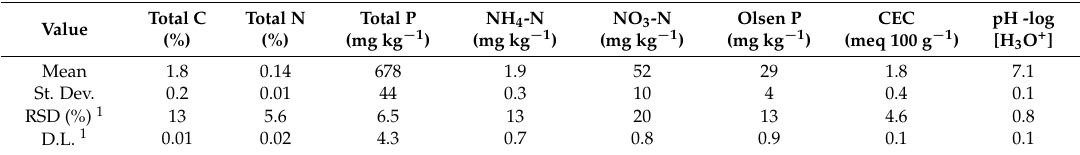
Table 2. Chemical characteristics of BSM.